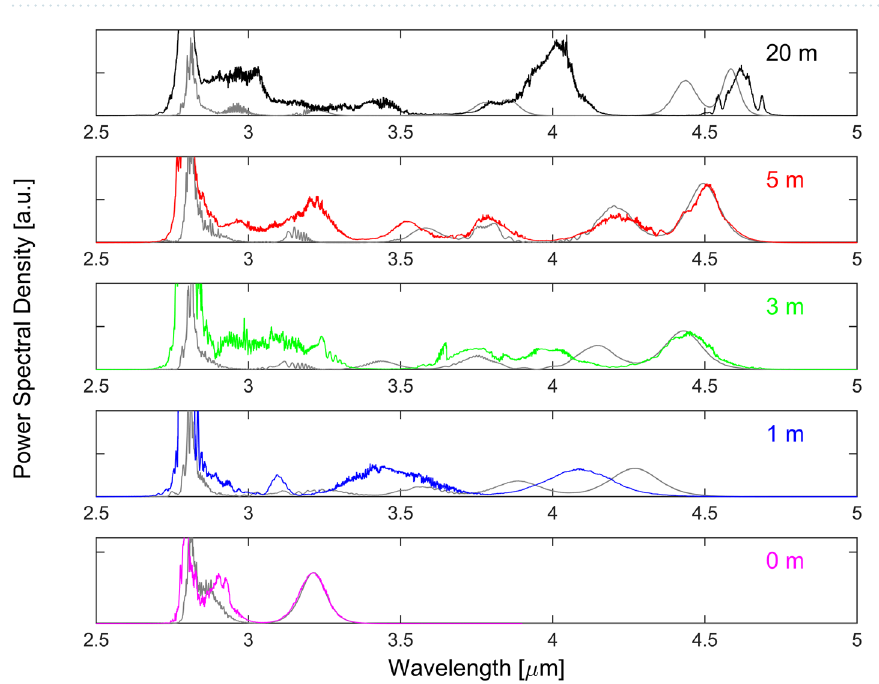
Figure 7. Simulated (gray) and experimental (colors) spectra for different propagation distances in the InF 3 fiber. The case labeled 0 m corresponds to the output of the Er: ZrF 4